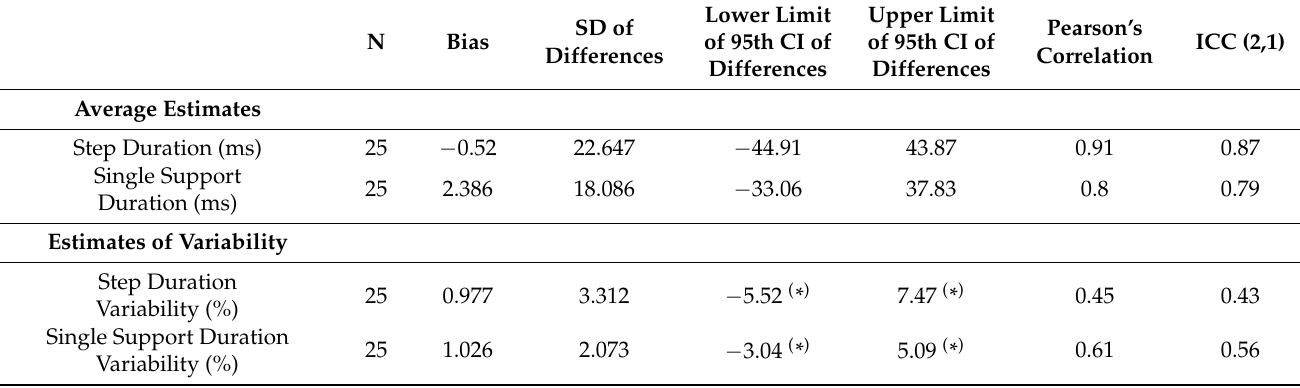
Table 5. Values of average estimates and estimates of variability for the bipedal gait parameters with the following statistics: sample size (N), the bias: mean of (insoles-GAITRite ® ), SD of differences: SD of (insoles-GAITRite ® ), lower and upper limits of 95th CI of differences, Pearson’s correlation and intra-class correlation coefficients between GAITRite ® and the insoles. ( * ) Note that the CI for the CV estimates are approximate only, based on t-intervals, as the underlying distribution is not